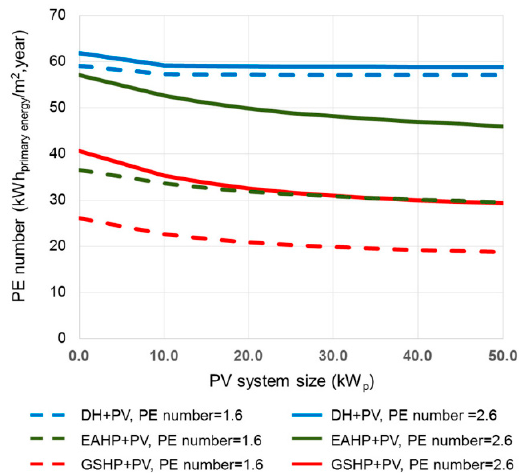
Figure 3. The PE number for the investigated building with different heating systems combined with a PV system, presented for PE factors of 1.6 and 2.5.